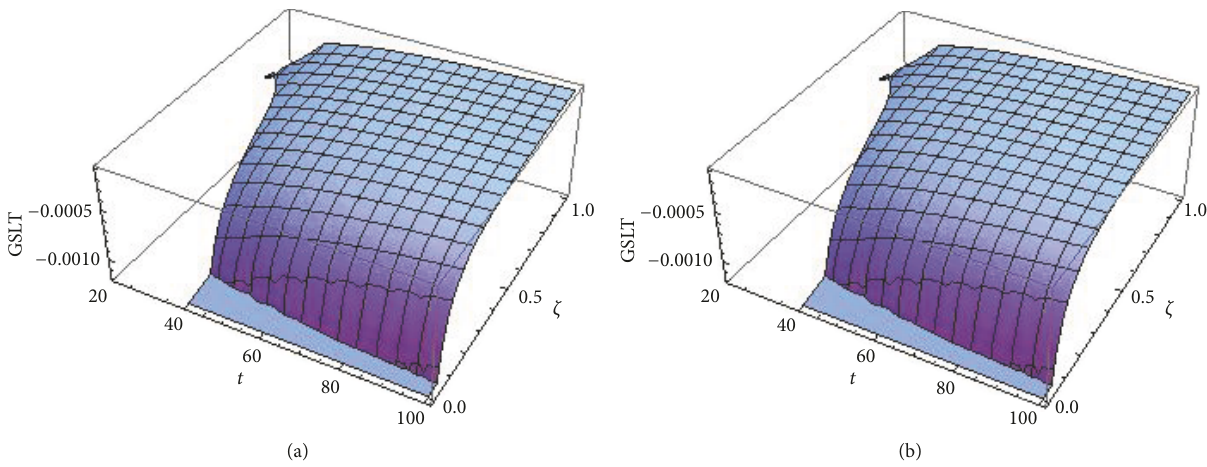
Figure 6: Validity of GSLT for the model (51). (a) is for 𝑑 1 = −1 with 𝑑 3 = 1 and (b) for 𝑑 1 = 𝑑 3 = −1 .